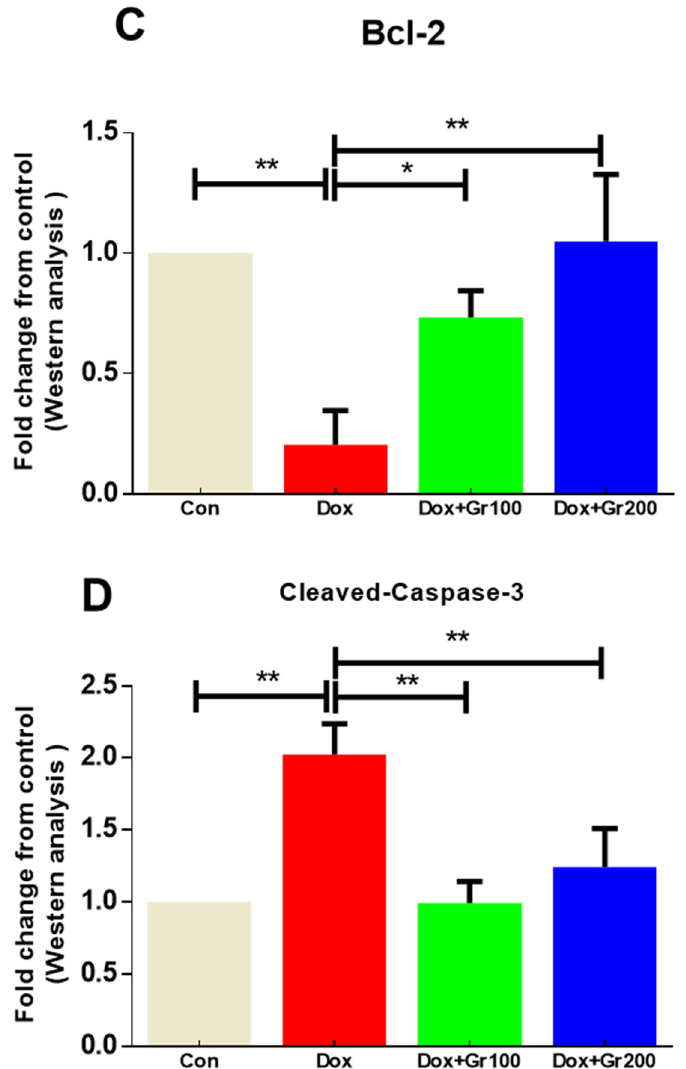
Figure 5. ( A – D ) Effects of geraniol (Gr), doxorubicin (Dox), or their combination (Dox + Gr100 and Dox + Gr200) on protein expression of apoptotic markers by Western blot. Data are presented as mean + SD (n = 6). *, p < 0.05; **, p < 0.01; ***, p < 0.001. Gr100 and Gr200 indicate 100 and 200 mg of geraniol per kilogram of body weight, respectively.